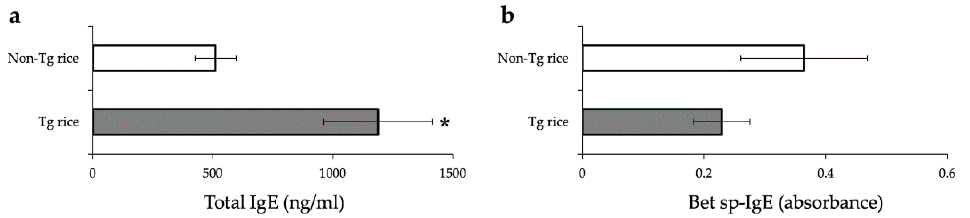
Figure 6. Serum concentration of total IgE ( a ) and Bet v 1-specific IgE ( b ) in mice fed with Tg or non-Tg rice. Data are presented as ng/mL or absorbance units. * p < 0.05, Tg vs. non-Tg rice-fed group according to unpaired Student’s t test (three mice per group).